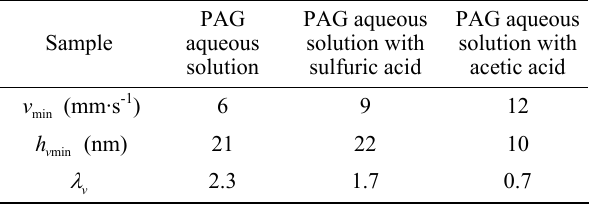
Table 2 Calculated theoretical film thickness and  values of different PAG aqueous solutions at minimal superlubricity